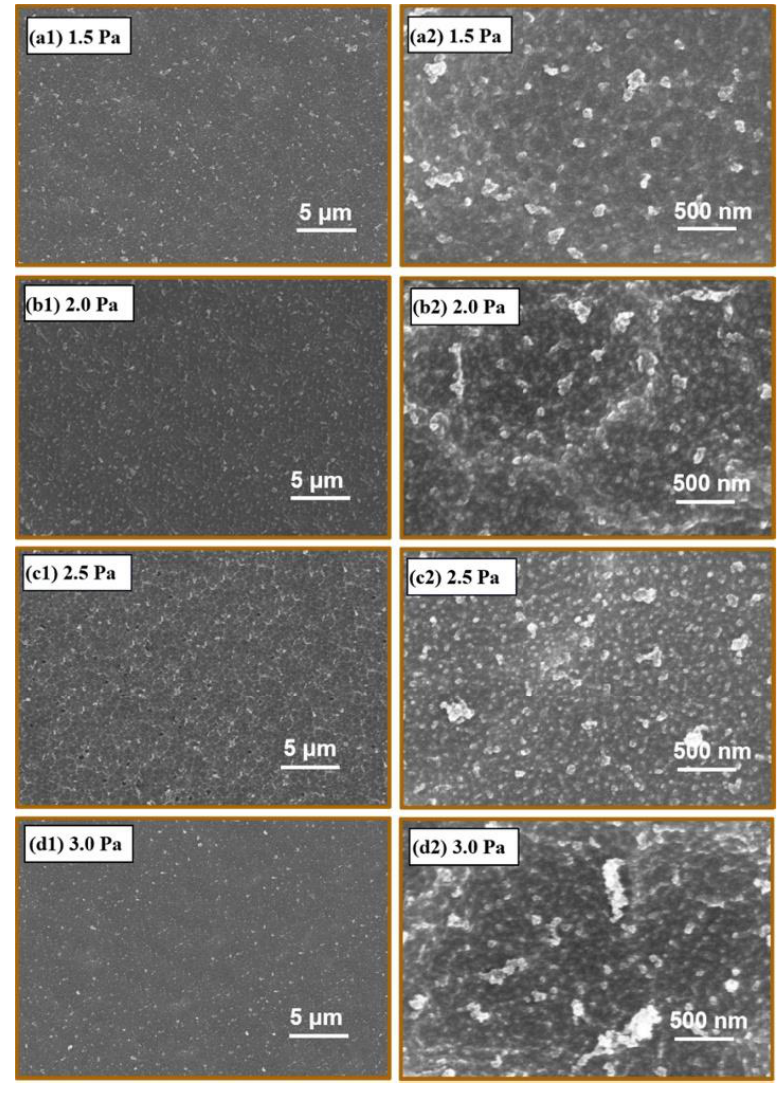
Figure 5. The SEM images of the surface morphology of Al 2 O 3 films prepared under ( a1 , a2 ) 1.5 Pa, ( b1 , b2 ) 2.0 Pa, ( c1 , c2 ) 2.5 Pa, and ( d1 , d2 ) 3.0 Pa. Figures ( a1 ) to ( d1 ) and ( a2 ) to ( d2 ) are the images with a 5 μ m and 500 nm scale, respectively. Reprinted with permission [60]; 2021, Elsevier. Cu (In 1-x ,Ga x ) Se 2 (CIGS) material belongs to I-III-IV group of quaternary compound